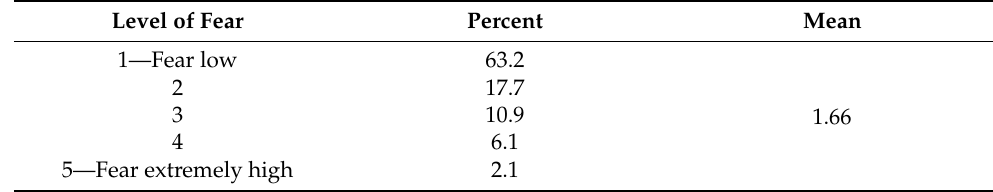
Table 3. Average percentage distribution of general anxiety defined by all marked feelings.